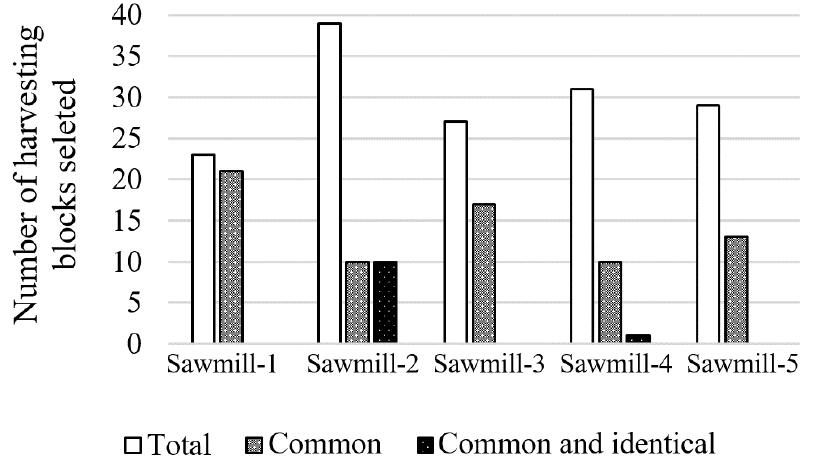
Figure 6. Comparing allocation of harvest blocks in mills between manual and optimal scenarios of reference.